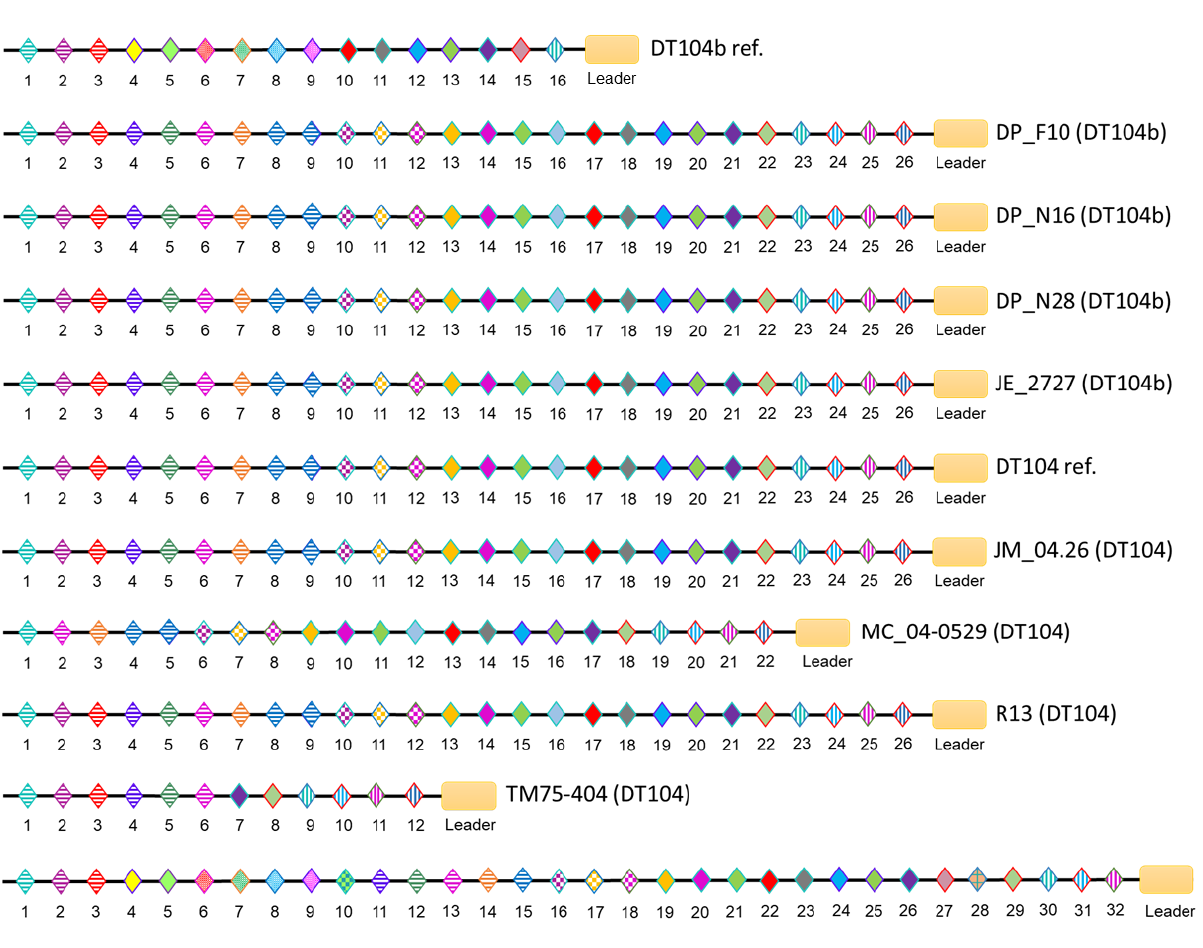
Figure 4. Schematic representation of CRISPR-2 locus in S . Typhimurium. The direction of spacers and repeats is shown, 5’ → 3’, with respect to the leader region (orange rectangle). The palindromic repeats (CGGTTTATCCCCGCTGGCGCGGGGAACAC) are shown as black horizontal lines. A distinctly coloured diamond represents each spacer. Strains DP_F10, DP_N16, DP_N28, JE_2727, DT104 reference (DT104 ref.), JM_04.26, and R13 harbour the same spacers ( n = 26), of which n = 24 (spacers 1–8, 10–25; spacer 9 is a duplicate of spacer 8) are commonly shared with LT2 (DT4). The DT104 strains MC_04-0529 and TM75-404 possess shorter CRISPR-2 arrays, n = 22 and n = 12 spacers, respectively; n = 20 spacers (1–11, 21; spacer 5 is a duplicate of spacer 4) of MC_04-0529 and n = 11 spacers (1–11) of TM75-404 are identical to spacers within the LT2 CRISPR-2 locus. The DT104b reference (DT104b ref.) strain possesses n = 16 spacers, of which n = 7 (spacers 4–9, 15) were unique to DT104b ref. and